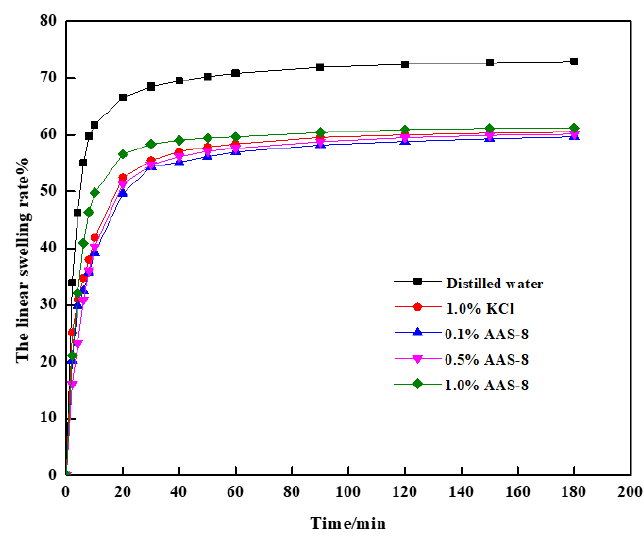
Figure 3. Selection of inhibitor